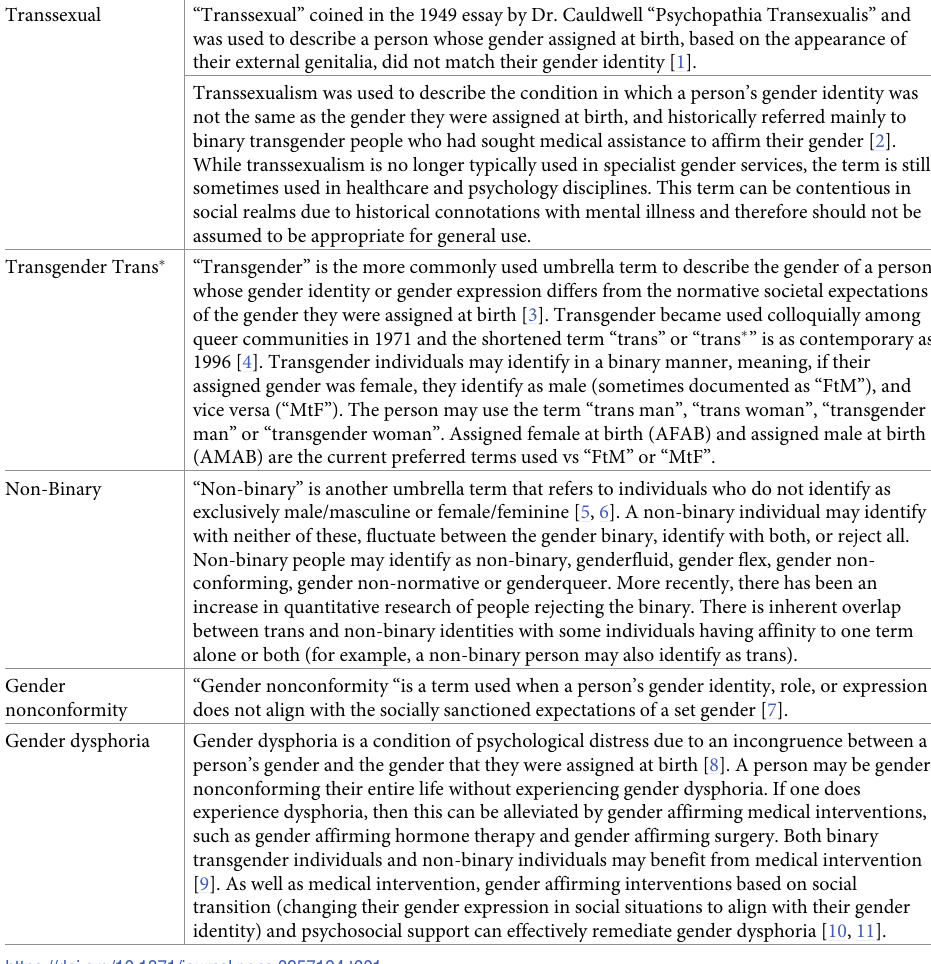
Table 1. Glossary of